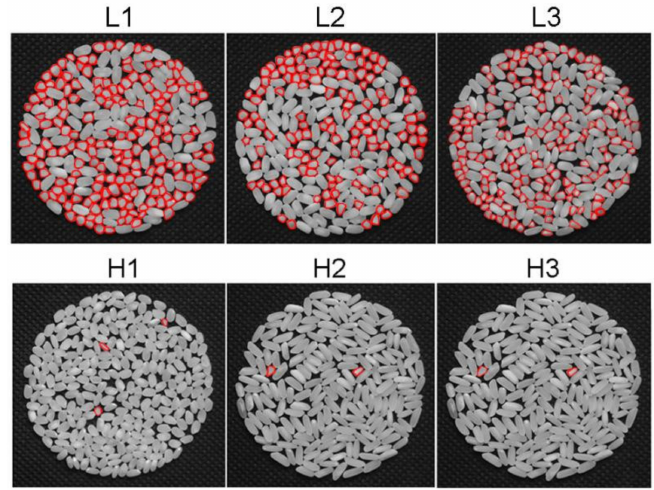
Figure 1. The HMRR phenotypes of L and H accessions. In total, 20 g of grains of each accession were dehulled by an electrical dehuller and then milled by a rice miller. The same weight of milled rice was used for the photograph. The broken milled rice are marked with red lines. Table 1. Information on the six rice accessions used in this study.